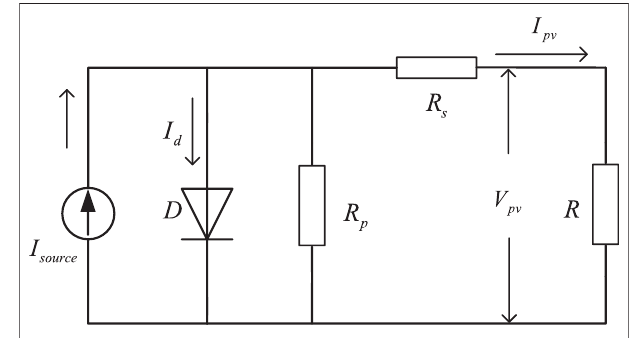
FIGURE 1 | The electrical circuit schematic of the PV